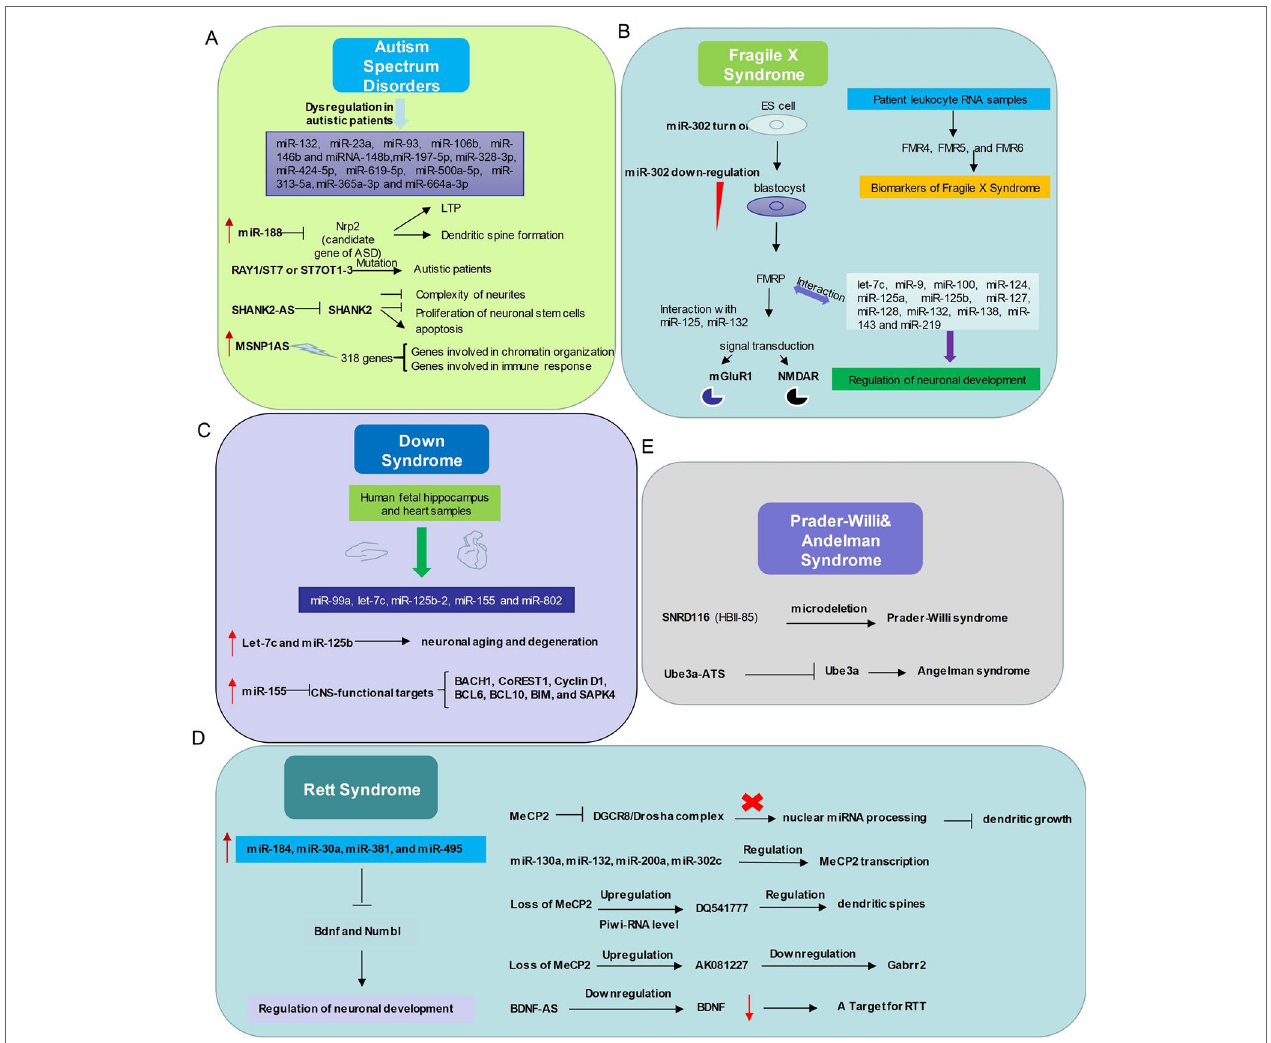
FIGURE 2 | Relationship between non-coding RNAs and neurodevelopmental disorders. (A) In Autism Spectrum Disorders, miR-132, miR-23a, miR-93, miR-106b, miR-146b and miRNA-148b, miR-197-5p, miR-328-3p, miR-424-5p, miR-619-5p, miR-500a-5p, miR-313-5a, miR-365a-3p and miR-664a-3p expression levels are abnormal. miR-188, RAY1/ST7 or ST7OT1-3, SHANK2-AS, MSNP1AS participate in ASD with distinct ways. (B) The interactions between non-coding RNAs and mechanism diagram of Fragile X Syndrome. microRNAs and long non-coding RNAs regulate Fragile X Syndrome process and might be a class of biomarkers of Fragile X Syndrome. (C) Dysregulation of microRNAs related to Down Syndrome in human fetal hippocampus and heart samples. (D) Left, the expression level of several microRNAs up-regulates in Rett Syndrome patients and these microRNAs play important roles in modulating neuronal development. Right, relationship between Mecp2 and Non-coding RNAs. (E) Microdeletion of SnoRNA SNRD (HBI-85) leads to Prader-Willi syndrome like phenotype. Long non-coding RNA Ube3a- ATS represses Ube3a, which gives rise to Angelman